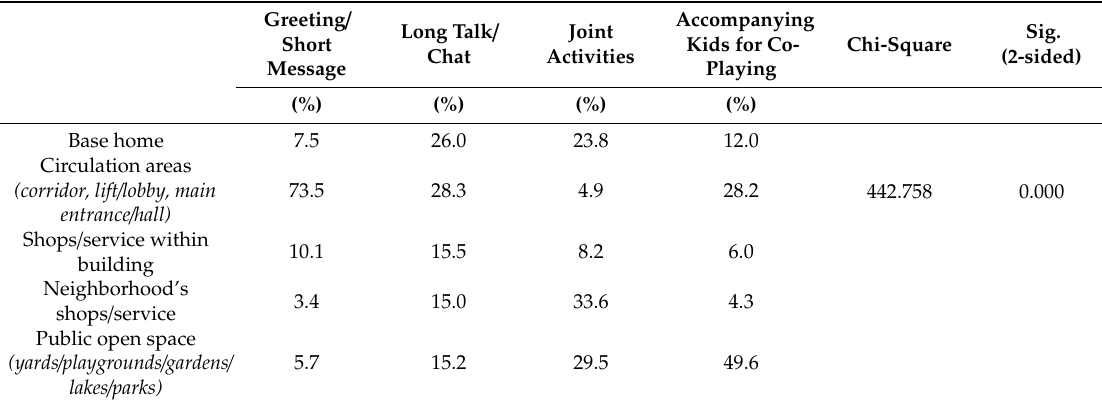
Table 4. Cross-tabulation of spaces used by main